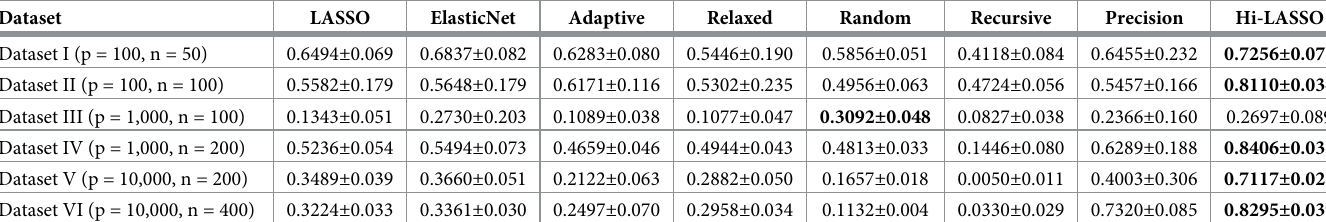
Table 1. Experimental results for feature selection performance (F1-scores) with the simulation data. Dataset LASSO ElasticNet Adaptive Relaxed